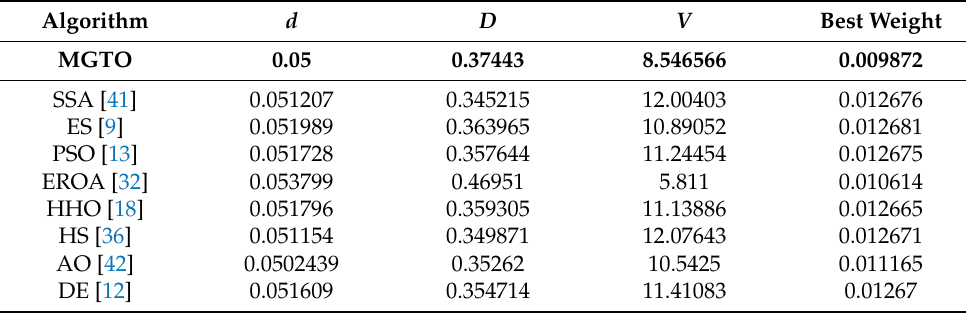
Table 12. Experimental results of the tension/compression spring design problem.